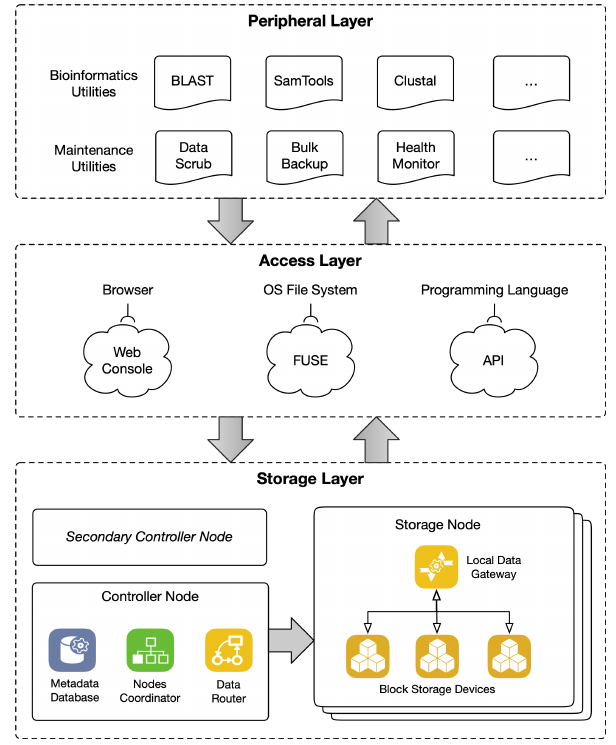
Figure 1. Three layer architecture overview of